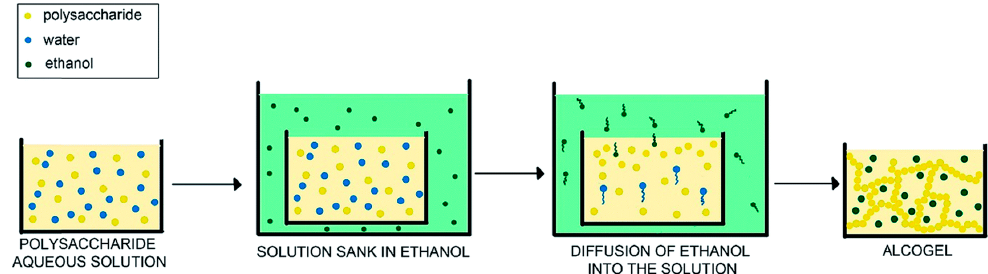
Figure 2. Schematic representation of the non-solvent induced phase separation process. Note that the actual volume of the alcogel is smaller due to shrinkage. Reproduced from [25] with permission of The Royal Society of Chemistry (RSC). The original RSC article is available online: http://dx.doi.org/10.1039/10.1039/C5RA14140K.